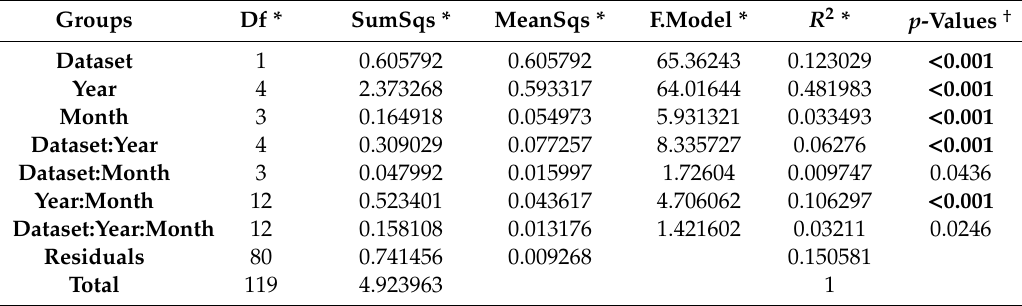
Table 1. Three-way permutational multivariate analysis of variance (PERMANOVA) showing the influence of di ff erent factors on β -diversity of bacterial communities based on weighted UniFrac distances. The rows ‘Dataset’, ‘Year’and ‘Month’ indicate RNA- or DNA-basedapproaches, successional stages and within-stage temporal turnover,